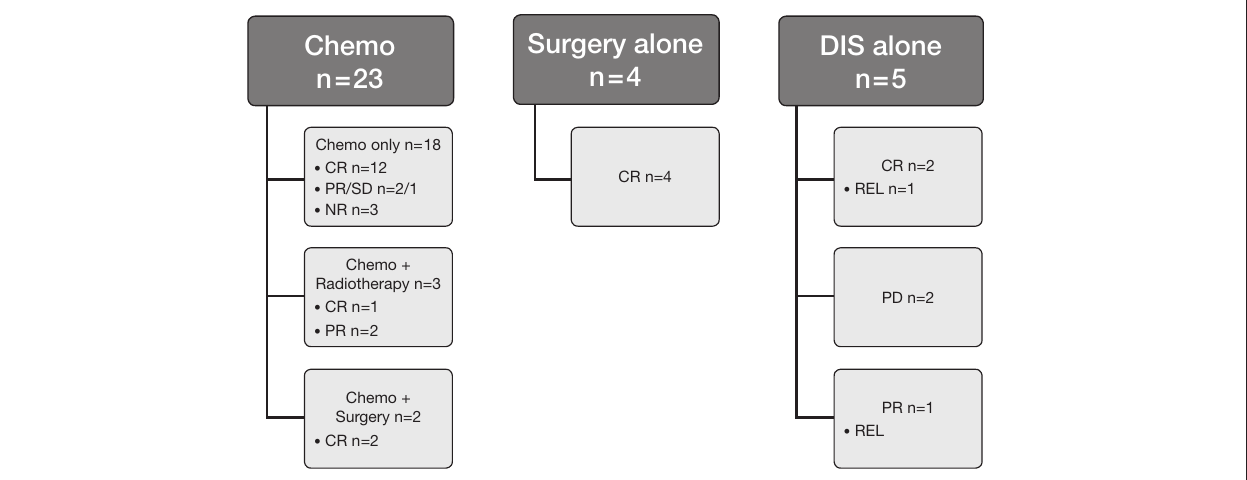
Figure 2) Various interventions offered to post-tranplant lymphoproliferative disorder (PTLD) patients and their responses. Chemo Chemotherapy; CR Complete response; DIS Decrease in immunosuppression; NR No response; PD Progressive disease; PR Partial response; REL Relapse; SD Stable disease Table 3 Results of chemotherapy in patients with post-transplant lymphoproliferative disorder Chemotherapy CR Relapse NR